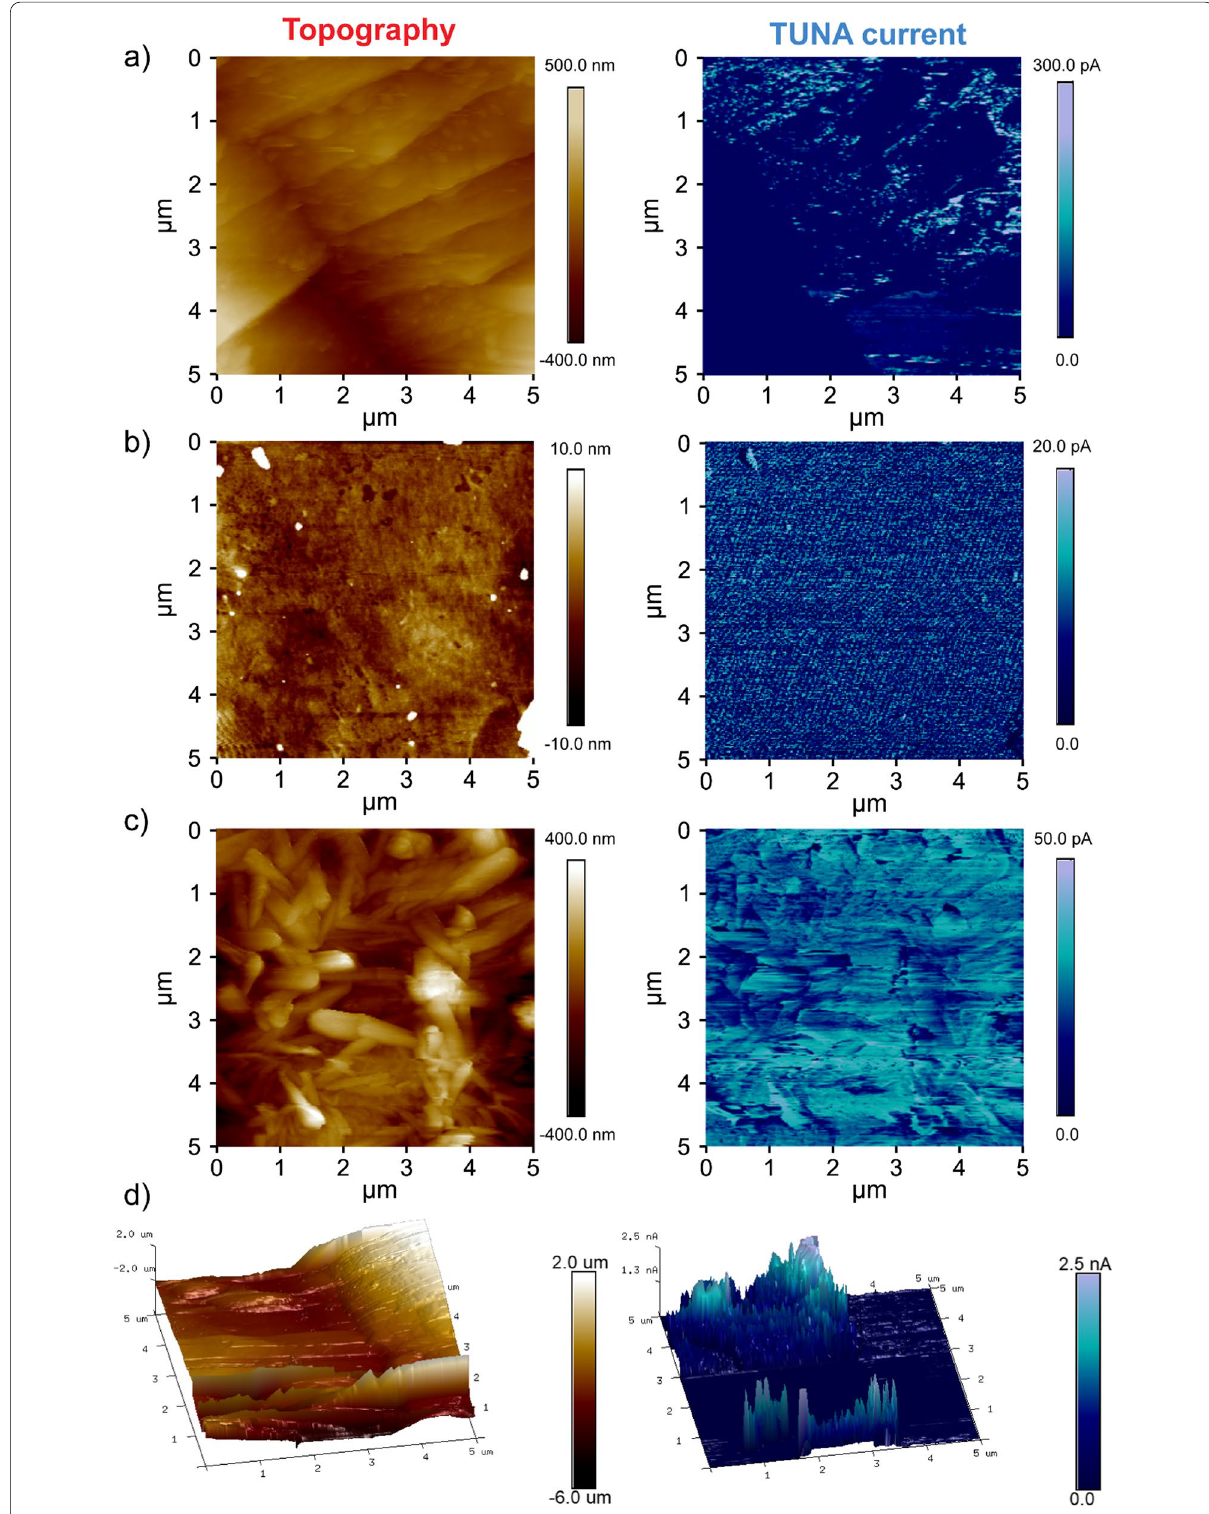
Fig. 3 Topography and TUNA current of the rest prepared chars. a ind700, b st300, c lig300, d lig700. “st”, “ind”, and “lig” represent chars derived from starch, indigo dye, and lignin, respectively. The suffix number represents pyrolysis temperature. Bias voltage applied for current mapping was 3, 10, 5, and 3 V, respectively, which was controlled according to the maximum limit of